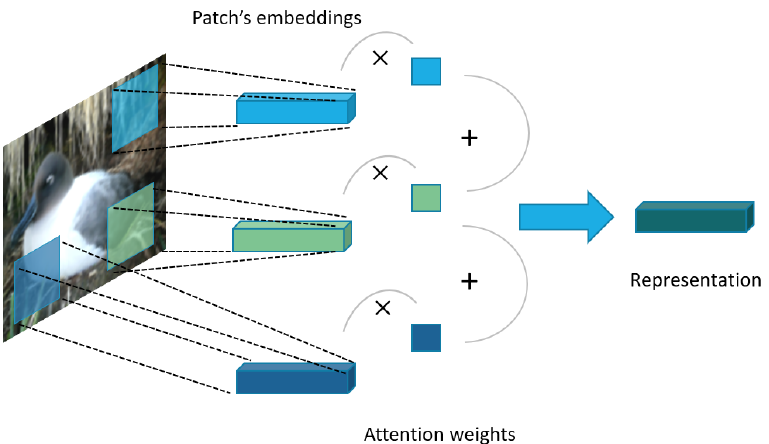
Figure 4. Extracting attention representation from Visual Transformer model: The output of the final encoder module of the ViT model includes N × N patch’s embeddings and N 2 × N 2 attention weights. The attention representation of an image is calculated by summation of the patches’ embeddings weighted by the attention scores.